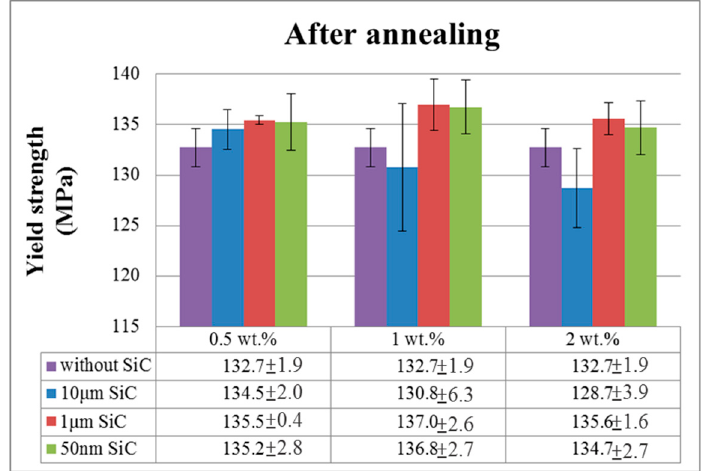
Figure 7. Yield strength of the AZ61/SiCp MMC extruded plates after annealing.